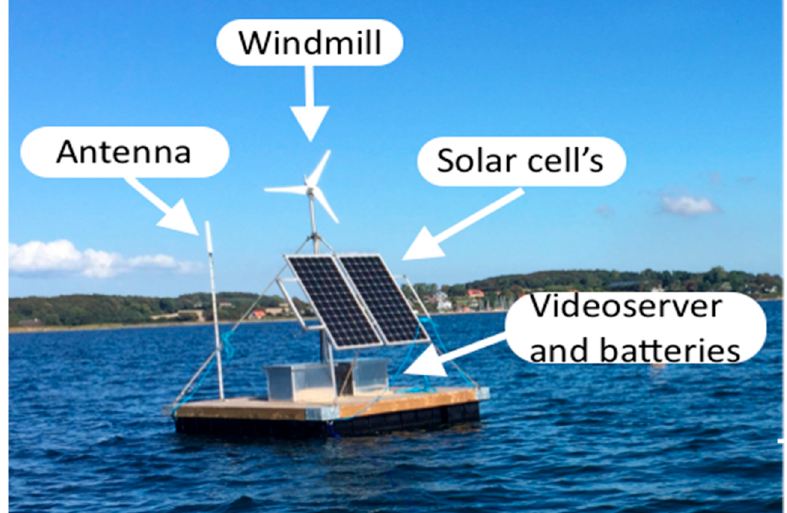
Figure 3. The pontoon anchored at the ferry with four chains. On the pontoon; a mounted antenna, windmill, solar cells, video server, and batteries supplying electricity for the cameras and light sources on the ferry.